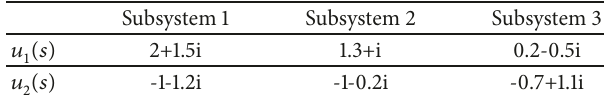
Table 3: Initial conditions of (2).